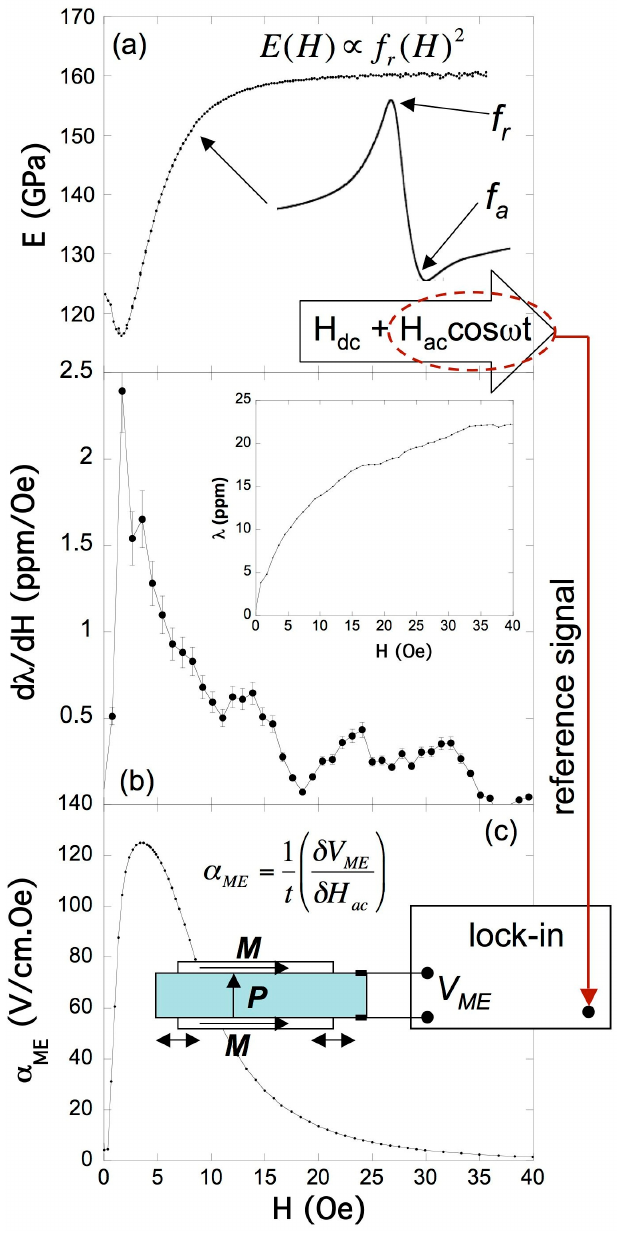
Figure 2. ( a ) Magnetoelastic resonance; ( b ) piezomagnetic coefficient or magnetostriction field derivative (the inset shows the magnetostriction curve) measurements performed on a long ribbon of as-cast Fe 64 Co 17 Si 6.6 B 12.4 amorphous magnetostrictive material; ( c ) ME measurements performed in a three-layer L-T sandwich configuration: the same previous magnetostrictive ribbon is longitudinally magnetized while the piezoelectric polymer (PVDF) is transversely poled.